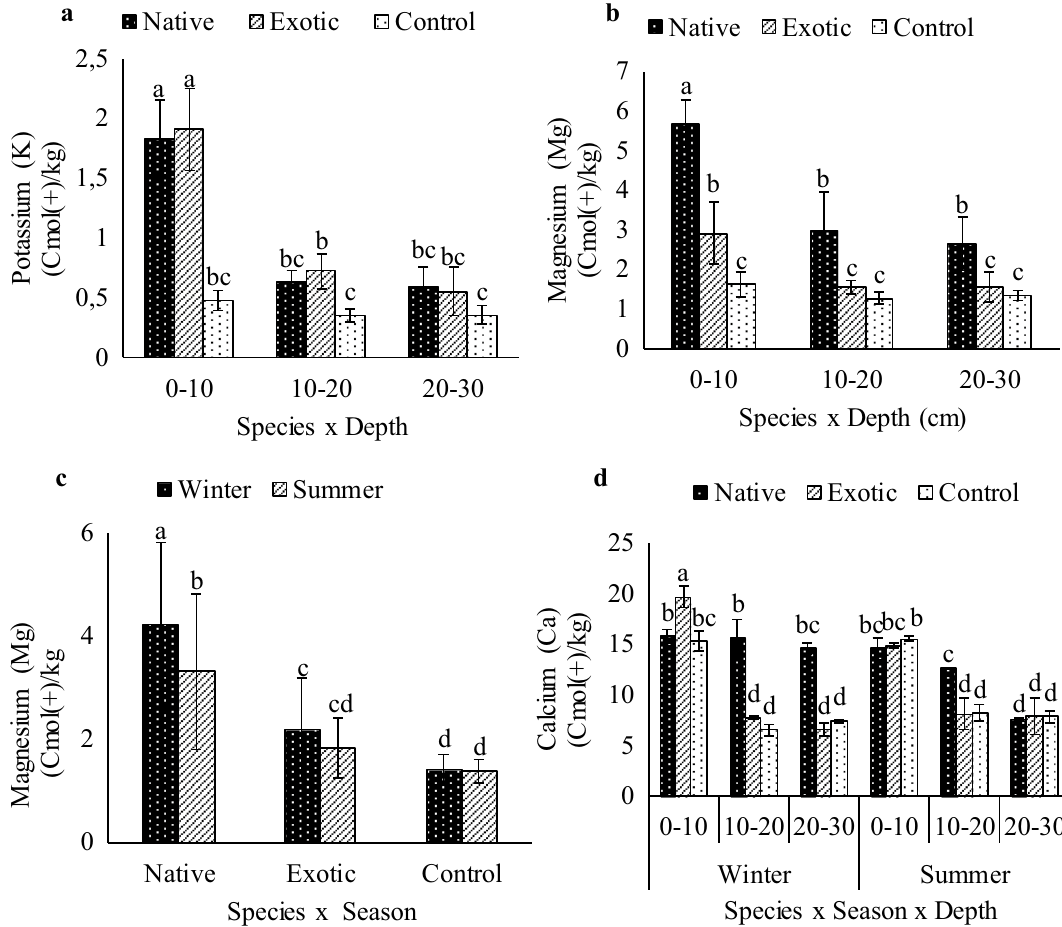
Figure 4. Influence of Tamarix species (exotic and native) on extractable cations ( a ) two way interaction (species × depth) on potassium, ( b ) two way interaction (species × depth) on magnesium, ( c ) two way interaction (species × season) on magnesium and ( d ) three way interaction on calcuim (Species × Season × Depth) at three soil depths (0–10, 10–20 and 20–30 cm) in two seasons (winter and summer). Means followed by different letters are significantly different from each other, with separation of means performed using Turkey’s test HSD. Bars indicate standard